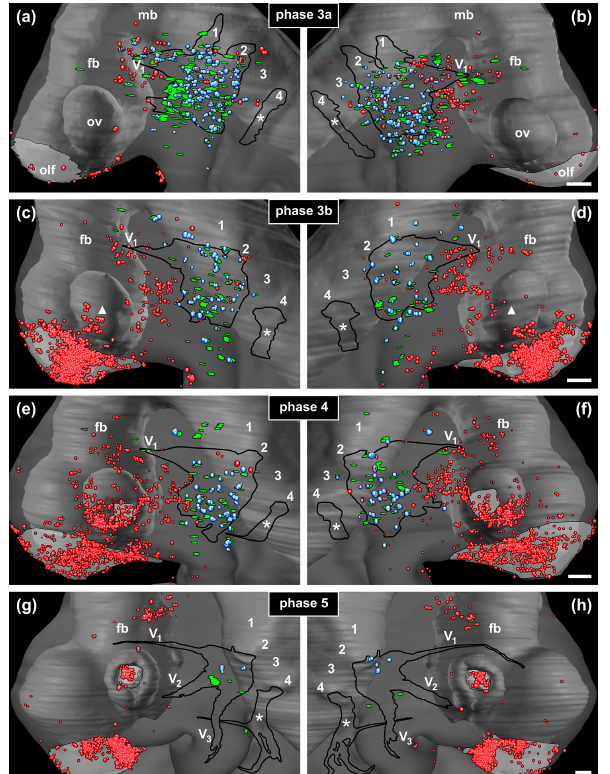
Figure 22. Early development of the trigeminal placode of Tupaia belangeri . 3-D reconstructions of embryonic heads from phases 1 and 2 of ocular development (left sides of the bodies: a , c , e , g ; right sides: b , d , f , h ) demonstrate focal trigeminal placodal thickenings (green) and delaminating placodal neuroblasts (blue) in the surface ectoderm (transparent gray), streams of neural crest cells/developing trigeminal ganglion (black lines), and pial brain surface (gray). (a–b) In phase 1a, the field of focal trigeminal placodal thickenings extends from positions adjacent to the fore- brain (fb) to rhombomere 1 (1). (c–h) In phases 1b, 2a, and 2b, the placodal field is gradually shifted caudally and, now, extends from positions adjacent to the midbrain (mb) to rhombomere 3 (3). Note the increase in the number of delaminating neuroblasts. 1–4, rhombomeres 1–4; oe, optic evagination; ov, optic vesicle. Scale bars = 100µm. Reproduced from Knabe et al. (2009, Fig. 2). © the authors